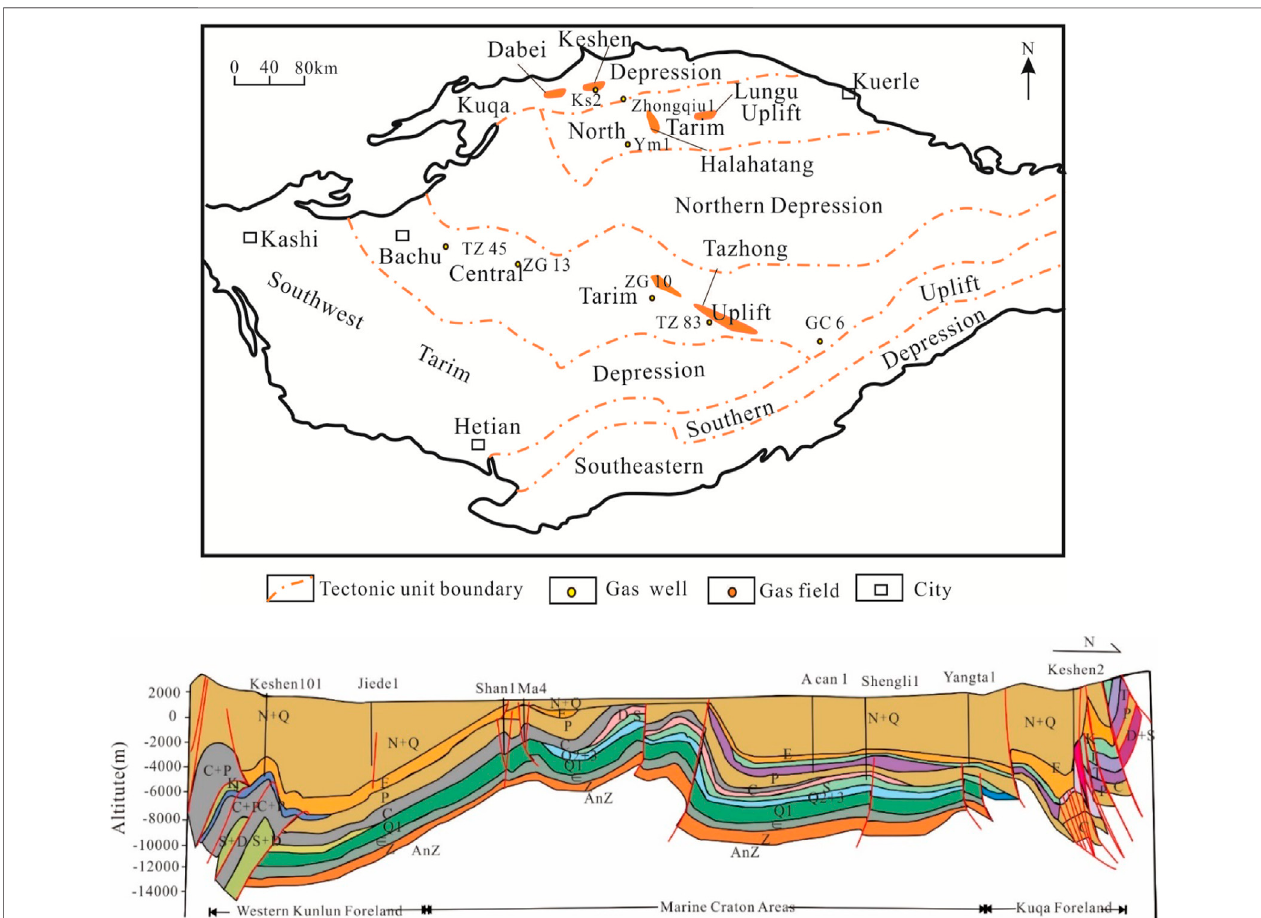
FIGURE 1 | Structural distribution map of Tarim Basin (the second map is according to Yang et al., 2019).